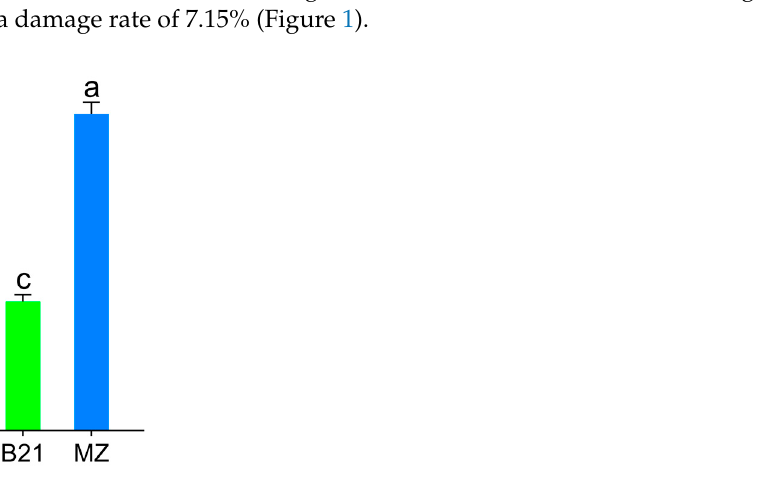
Figure 1. The damage rate by C. nucum at harvest in three cultivars investigated in Yitong country (NE China), based on three years (2019, 2020, and 2021). Bars with different letters are statistically different (Tukey test, p < 0.001, F = 397.894).